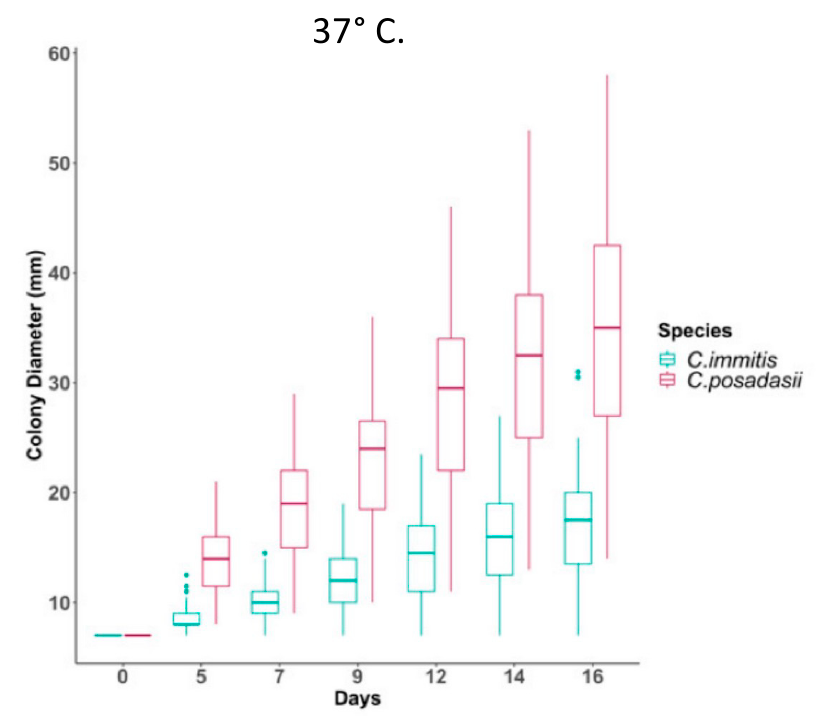
Figure 3. Temperature impacts growth ability of C. immitis isolates compared to C. posadasii on yeast extract media. Radial growth measurements at 37 °C for 46 C. posadasii and 39 C. immitis isolates in triplicate. The figure is from [23] .